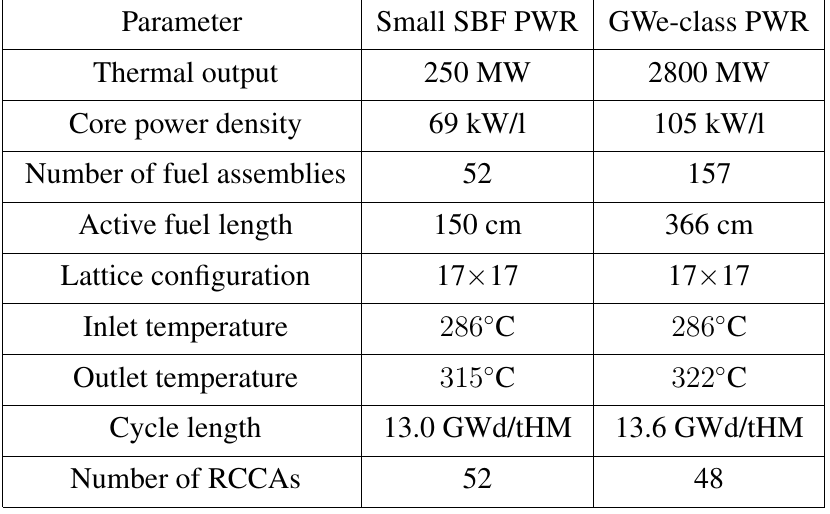
Table 1: Comparison of core parameters between the small soluble boron free (SBF)